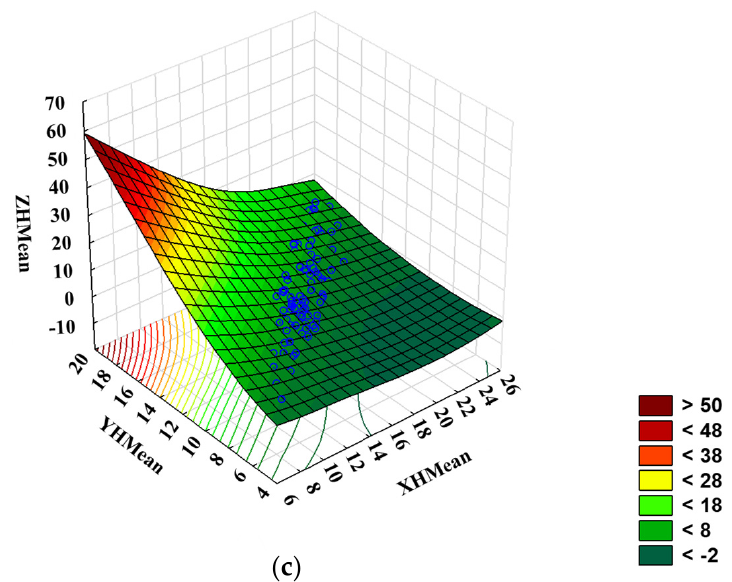
Figure 3. Surface chart 3W of textures RHMean vs. GHMean vs. BHMean from the color space RGB ( a ), LHMean vs. aHMean vs. bHMean from the color space Lab ( b ), and XHMean vs. YHMean vs. ZHMean from the color space XYZ ( c ).